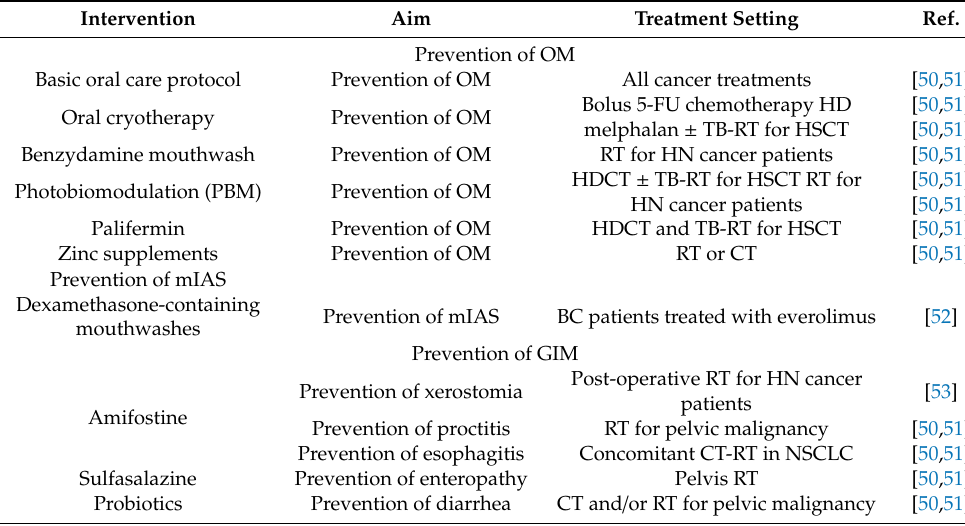
Table 1. Prophylaxis strategies for oral and gastrointestinal